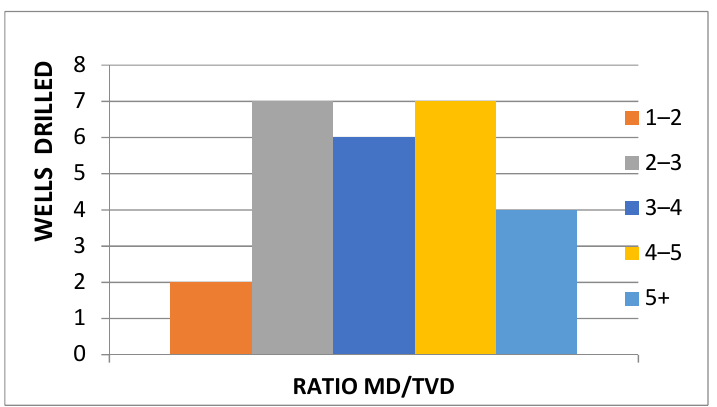
Figure 5. The ratio between measured depth (MD) and true vertical depth (TVD) of 26 analyzed wells.